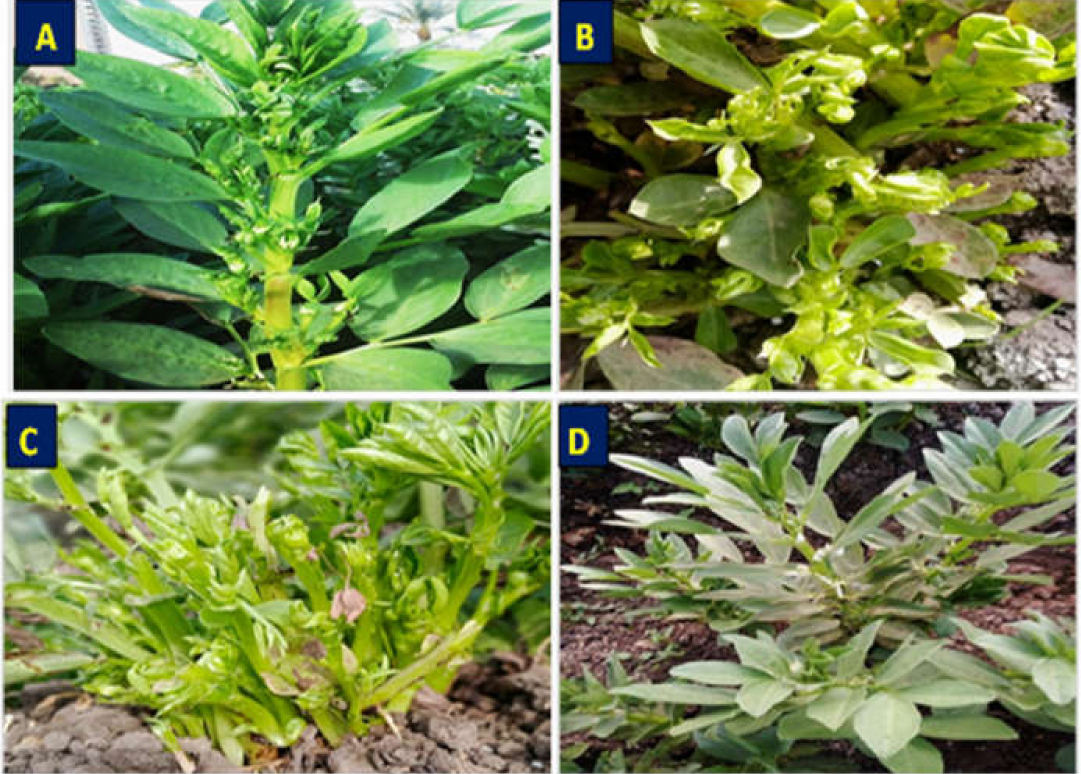
Figure 3. Naturally infected faba bean plants showing phytoplasma disease; ( A ) phyllody symp- toms; ( B ) yellowing and little leaves; ( C ) shoot proliferation, witches’ broom, and stunting, and ( D ) asymptomatic faba bean